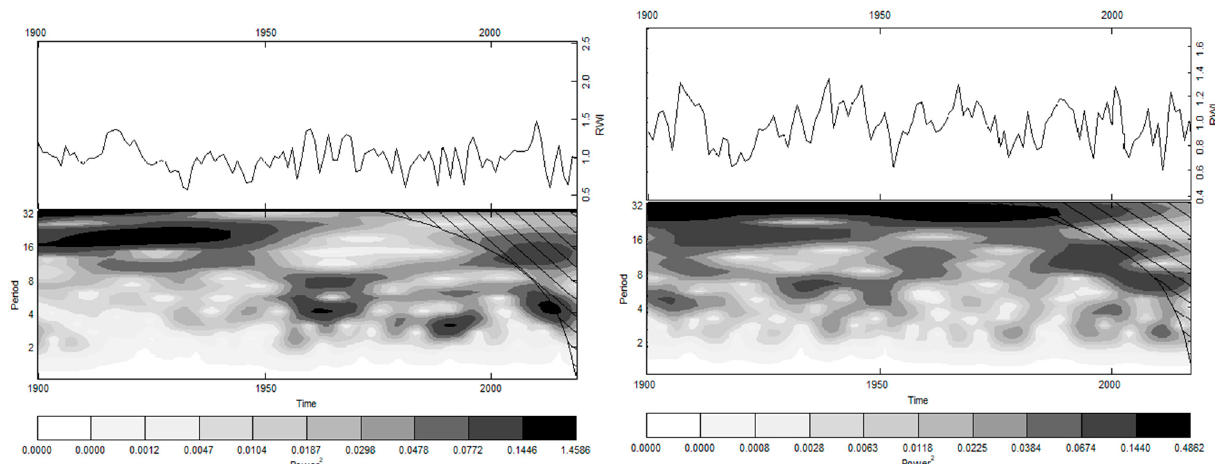
Figure 6. Wavelet plot calculated from mean RWI (ring width index) of European beech stands in the Krkonoše mountains in Poland and the Czech Republic ( left ) and plots in Italy in the Apennines mountains ( right ). Black color represents the 90% significance level against the dark gray noise level.